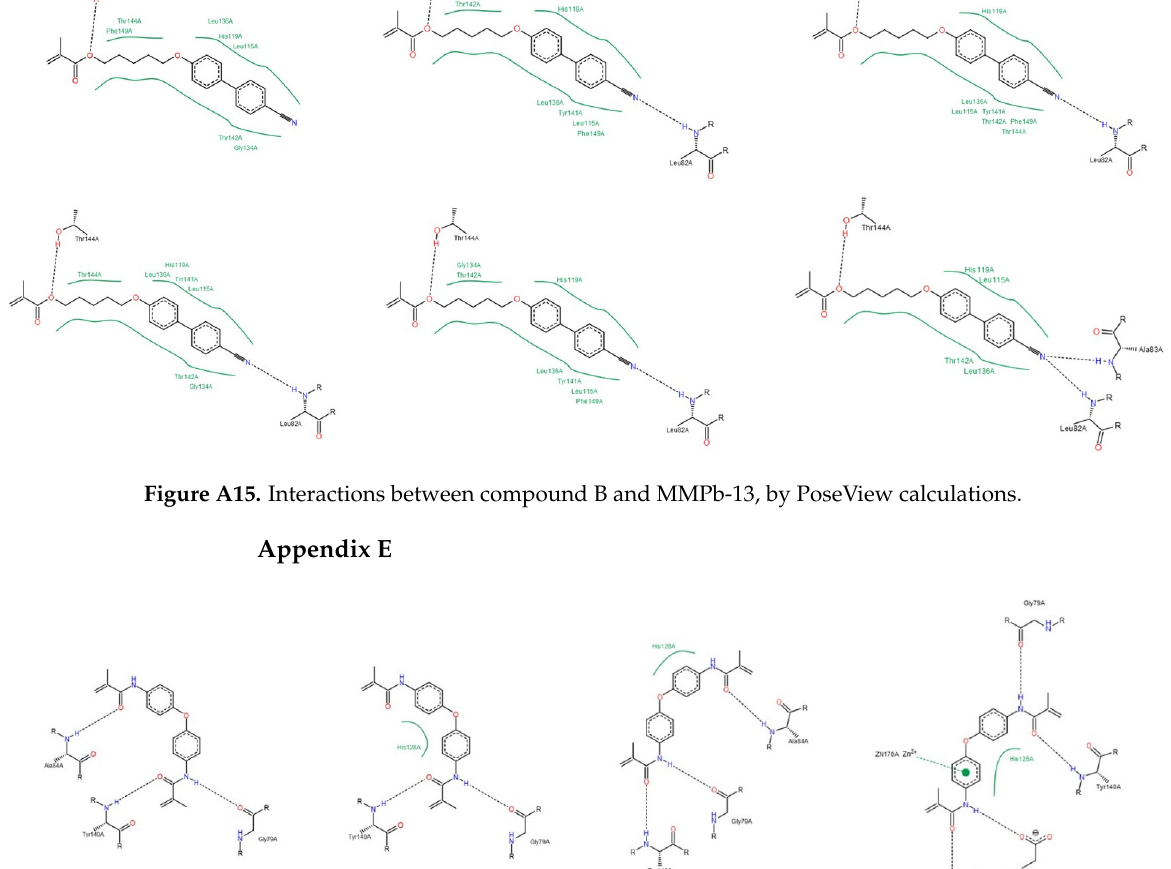
Figure A14. Interactions between compound B and MMP-9, by PoseView calculations.